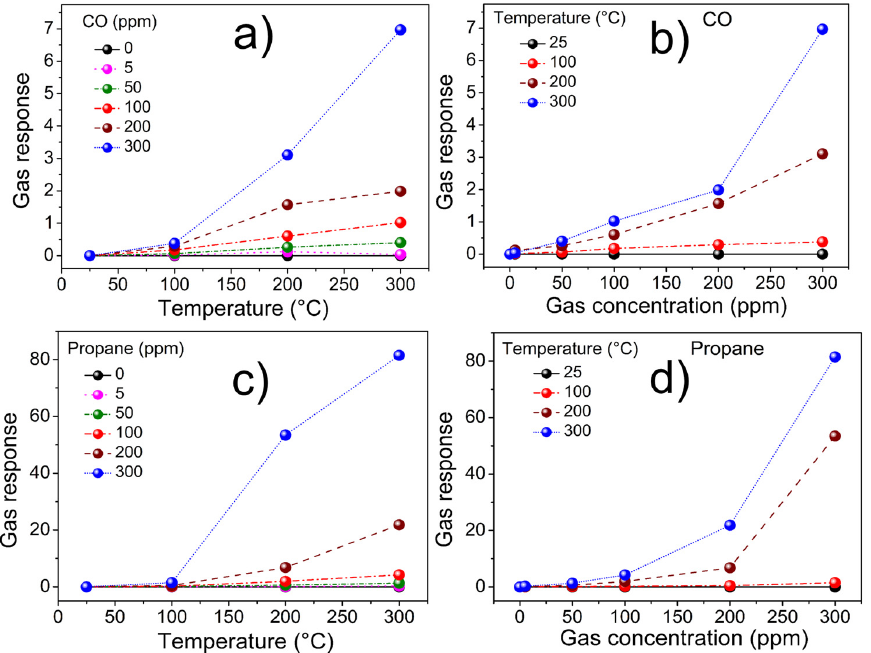
Figure 11. Response of ZnAl 2 O 4 pellets as a function of operating temperature and concentration: ( a , b ) CO, ( c , d ) propane.